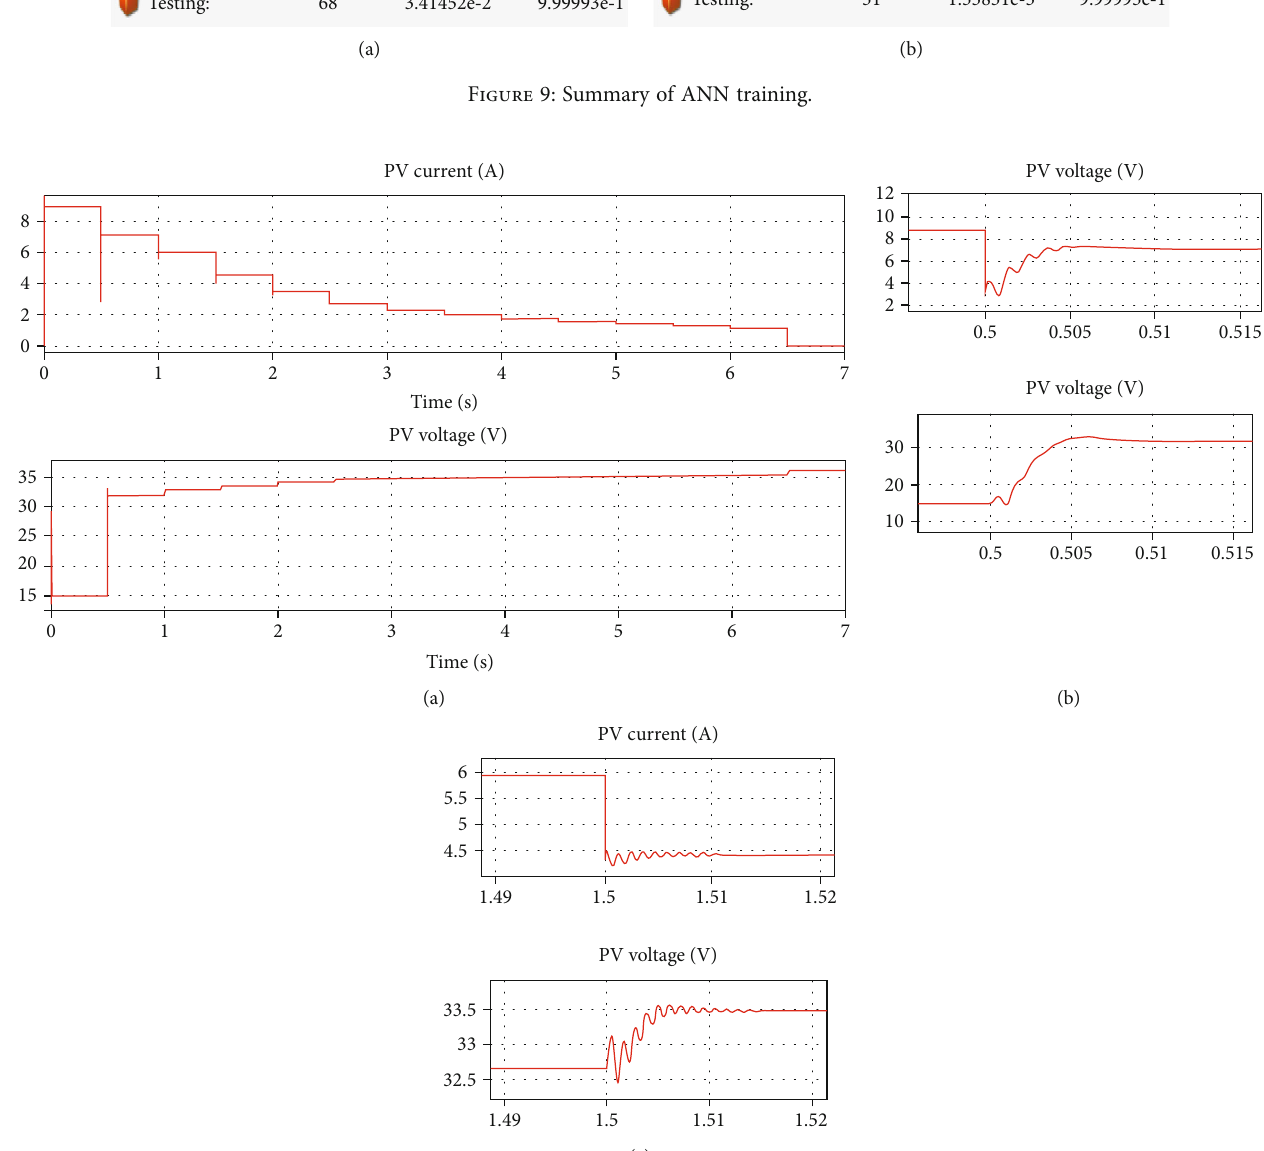
Figure 10: PVE current and voltage under uniform irradiance condition for load change case. (a) Entire curve. (b) Transient response at t = 0 : 5 s . (c) Transient response at t = 1 : 5 s .